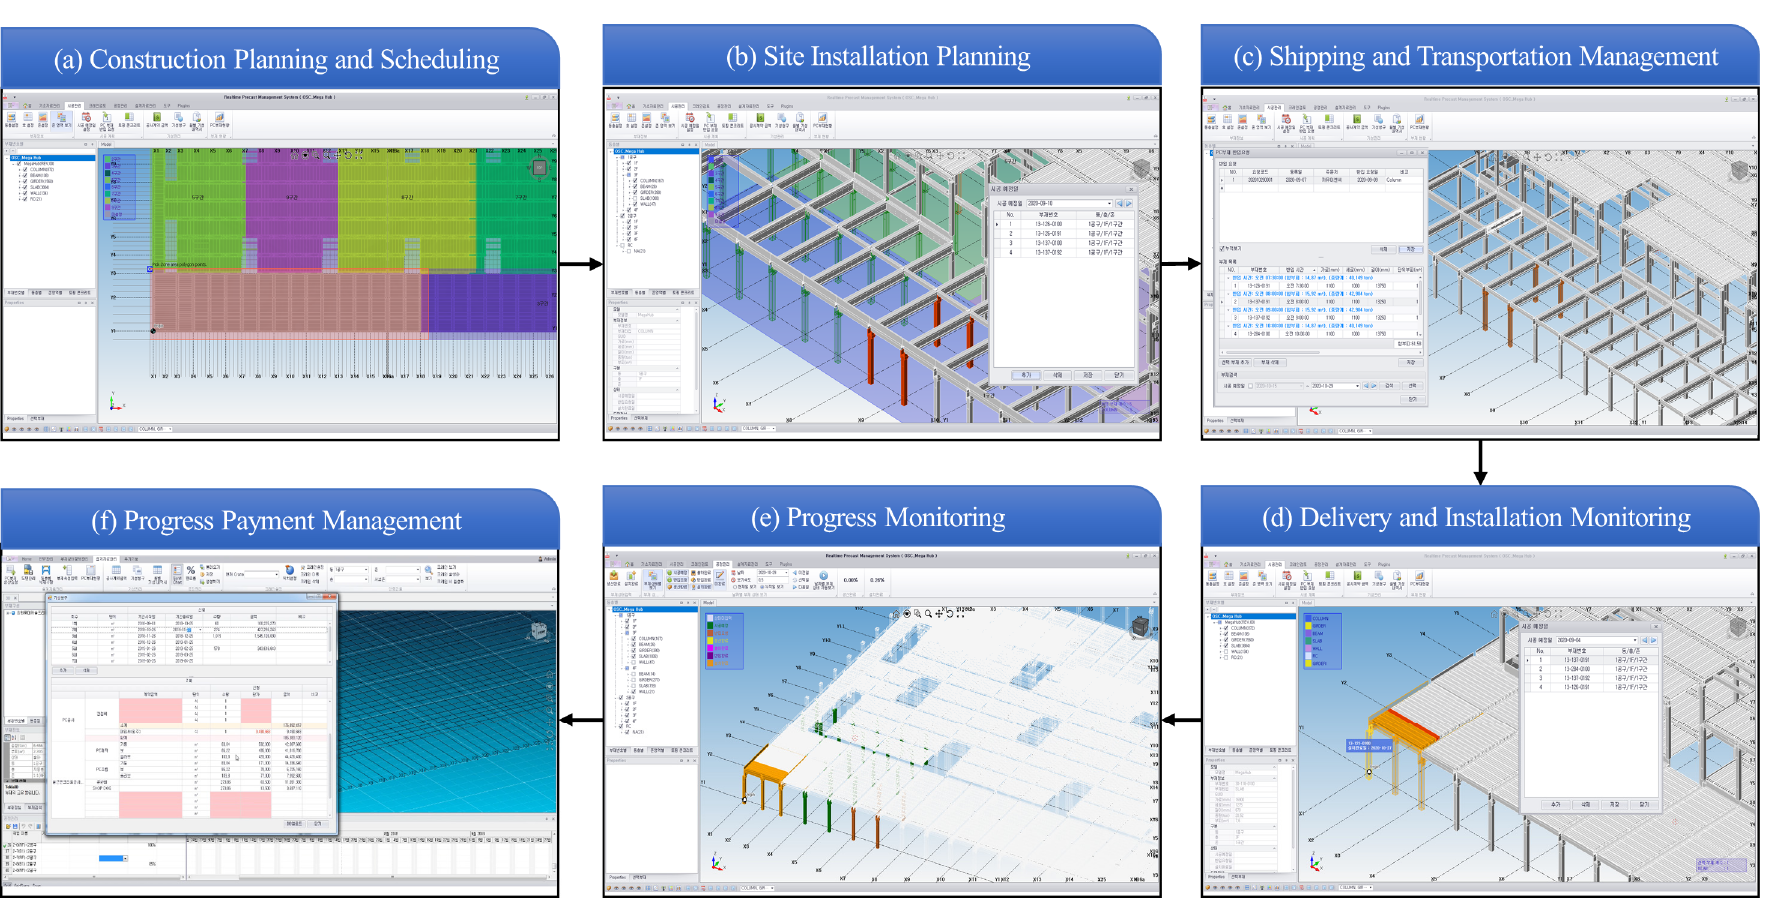
Figure 3. OSC-IMS user interface.